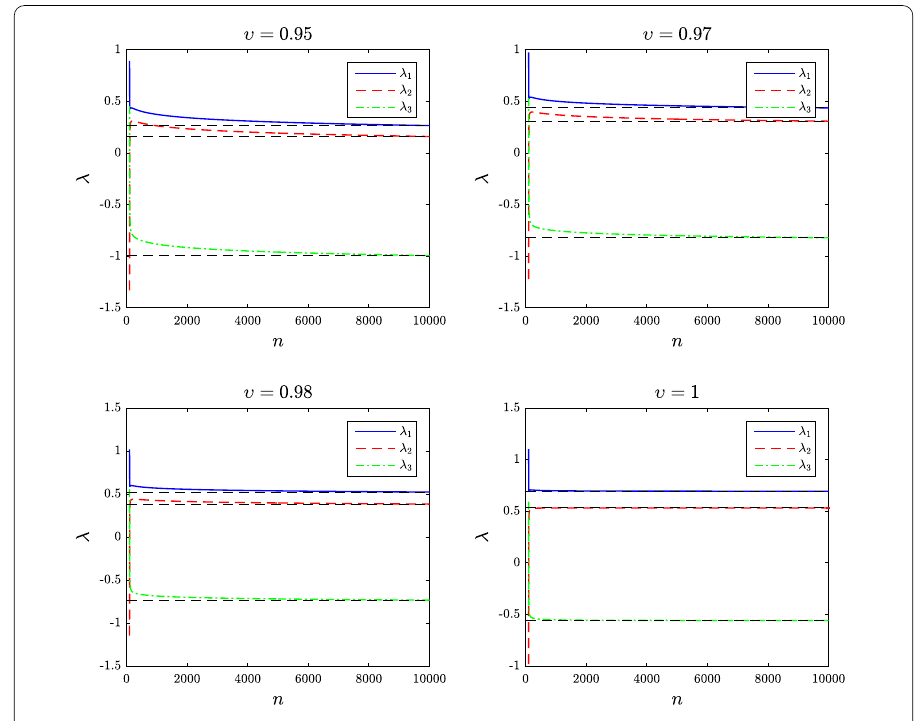
Figure 20 Estimated Lyapunov exponents of the fractional Wang map for with ( a